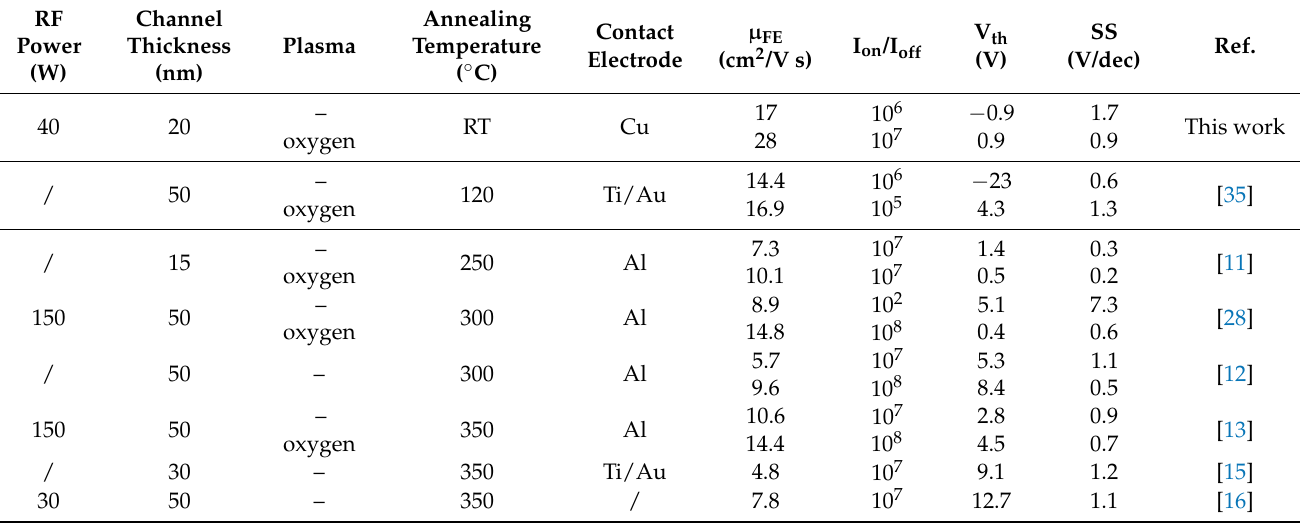
Table 4. Comparison of preparation parameters and electrical properties of various a-InGaZnO TFT deposited by sputtering.